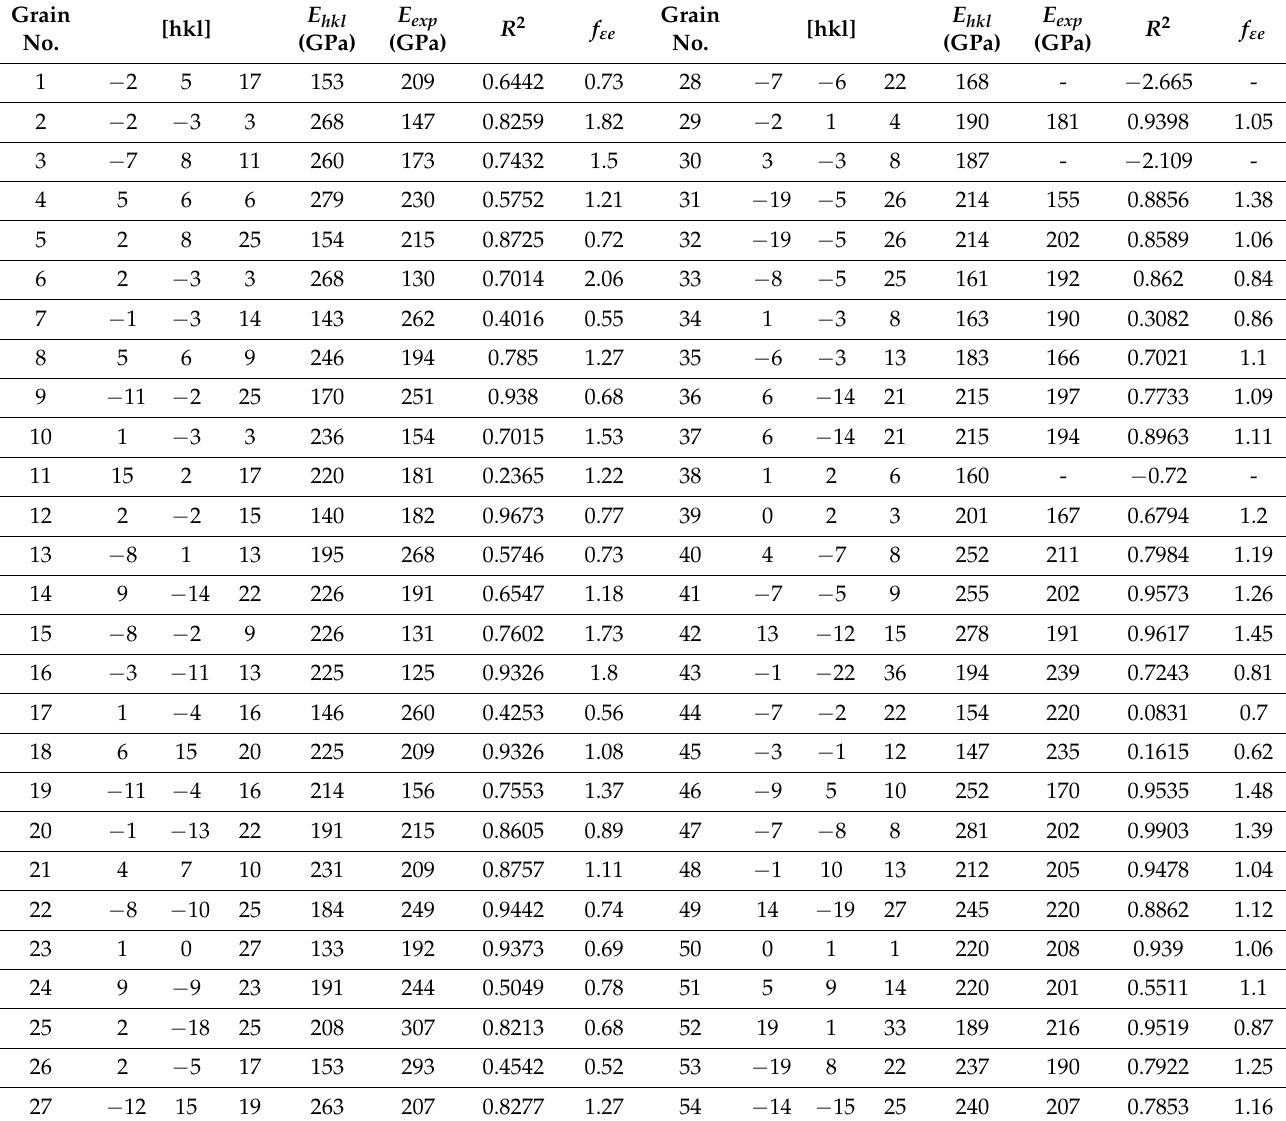
Table 1. Young’s modulus and elastic–strain ratio of individual